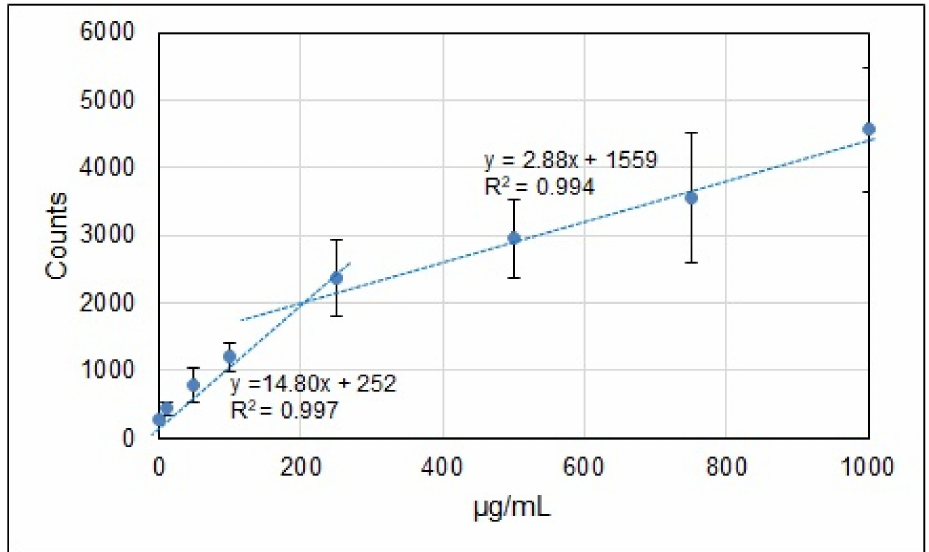
Figure 4. Double-line approximation of the data for K